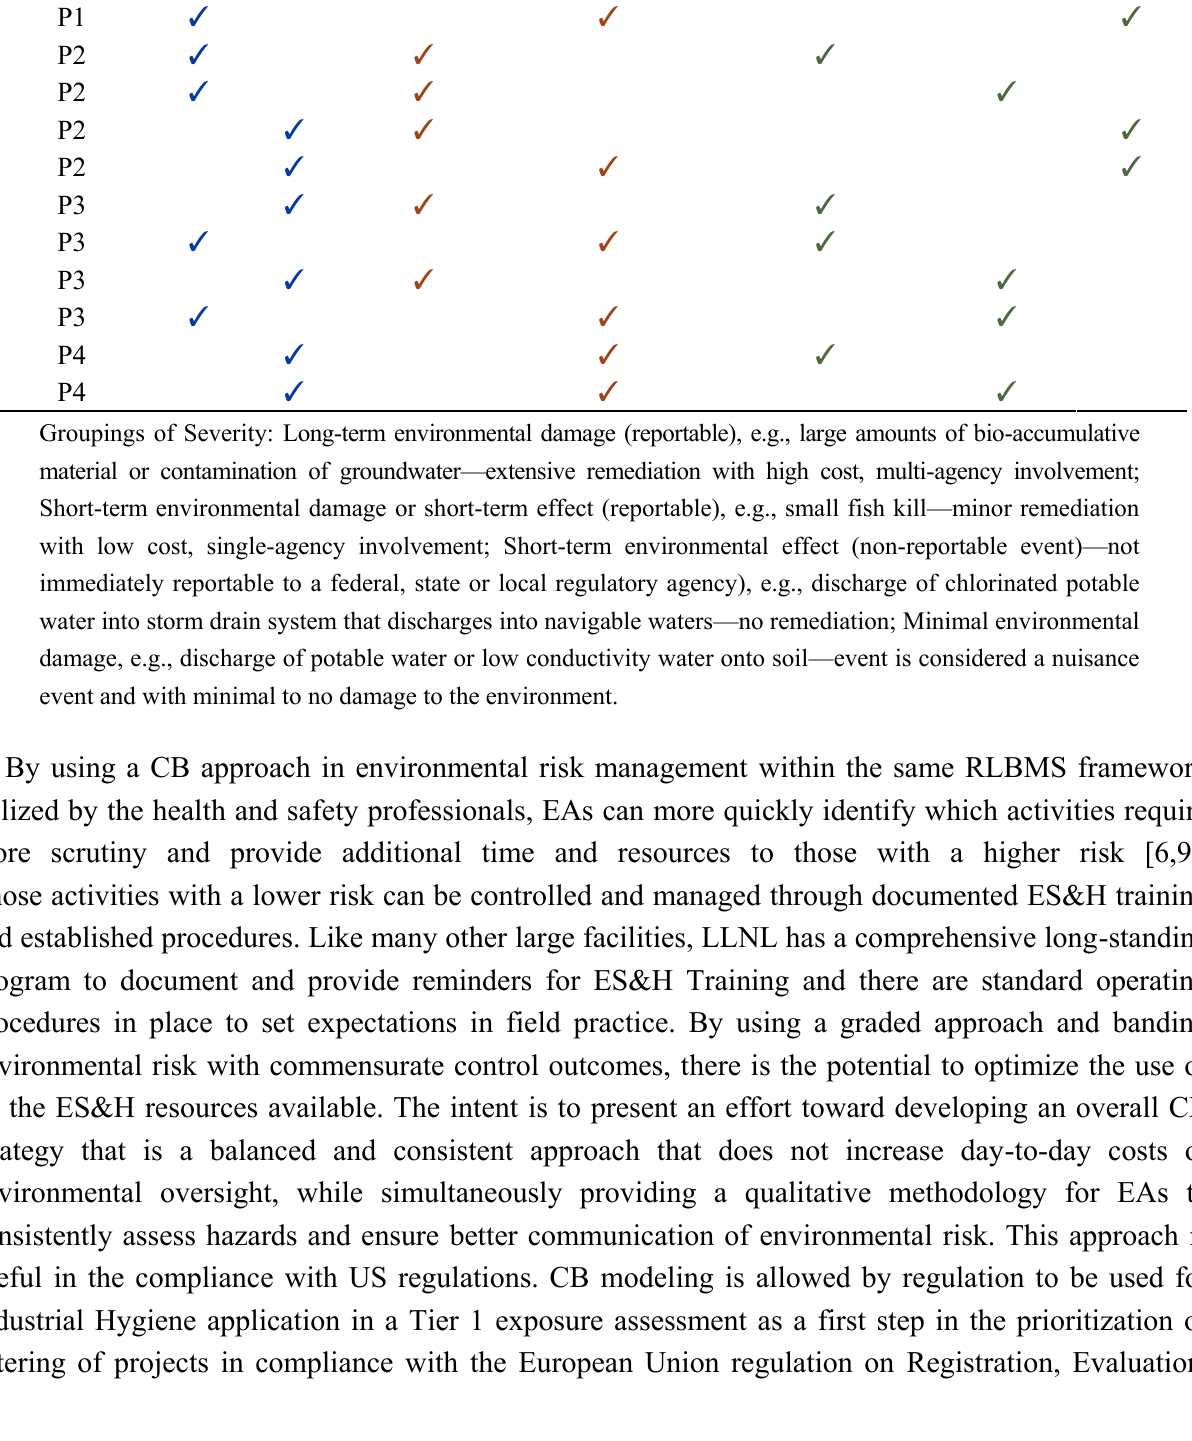
Inadequate & Regulated Environ. Uncontrolled Material/Waste Permit